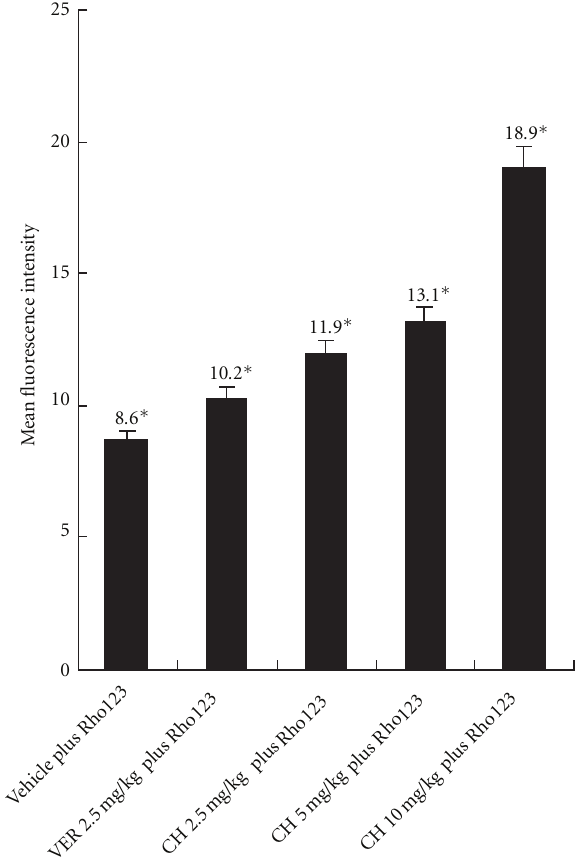
Figure 3: Accumulation of Rho123 in CD8 + cells by di ff erent doses of reversors with or without Rho123 at a dose of 2.5mg/kg in vivo . The increase of the mean fluorescence intensity that reflects the e ffl ux is inhibited. ∗ P < 0 . 05, di ff erent from the control. The results are the mean ± SD of at least 4 independent